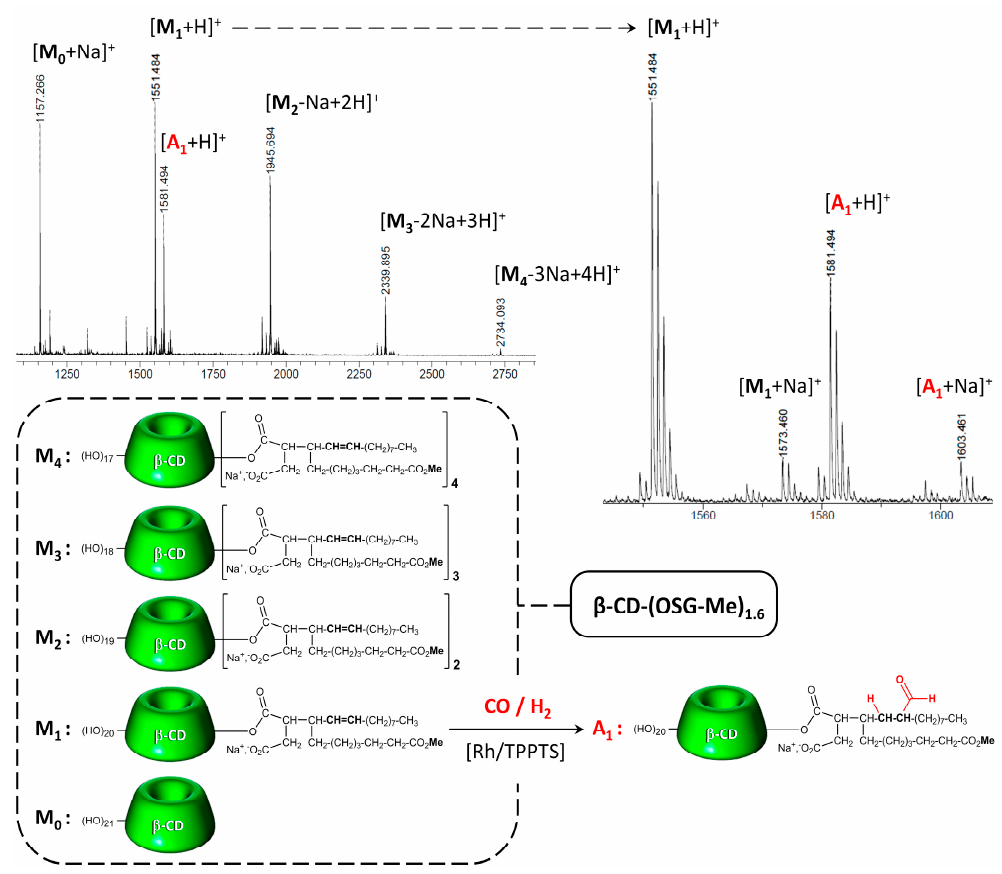
Figure 1. Matrix-assisted laser desorption/ionization mass spectrometry (MALDI-MS) spectrum of β -CD-(OSG–Me) 1.6 after treatment with Rh(acac)(CO) 2 / TPPTS catalytic system (1 and 5 molar equivalents with respect to CD). Experiment conditions: pressure, 50 bar of CO/H 2 (1:1); solution, 6 mL H 2 O for every 21 μ mol of cyclodextrin (CD); temperature, 80 °C; time, 6 h.